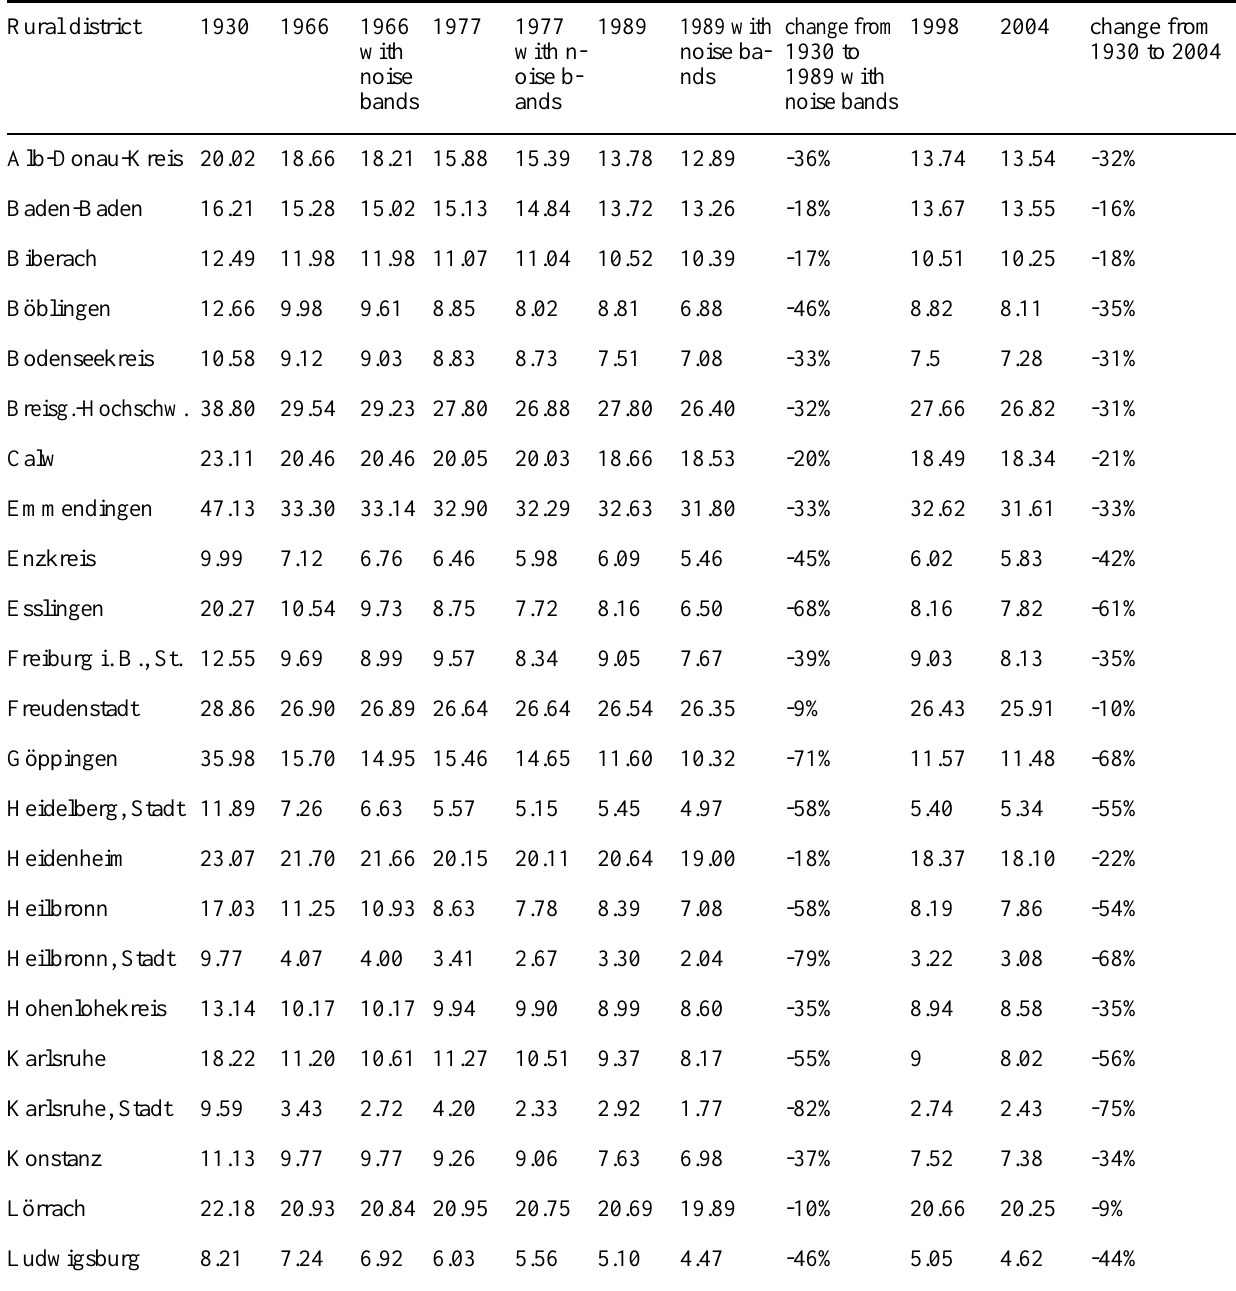
Table 3. Data on the development of the degree of landscape fragmentation in the 44 rural districts, or counties, of Baden-Württemberg (excluding municipal roads); for the years 1966, 1977, and 1989, a comparison with and without noise bands was included. All values are based on the cutting-out (CUT)